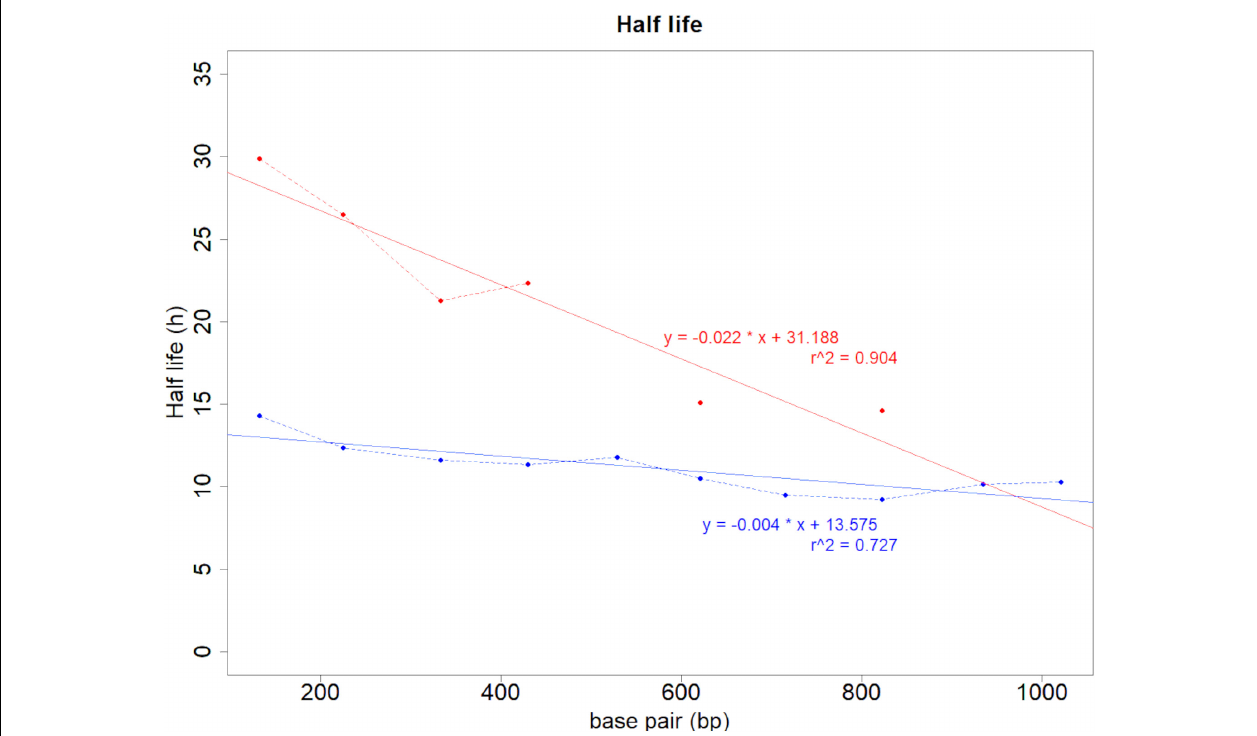
FIGURE 5 | Half-life results calculated from the decay rate. The vertical axis shows the half-life (hours), and the horizontal axis shows the sequence lengths. The blue line shows the change in total eDNA copy number, and the red line shows the change in intracellular eDNA copy number. At 529, 715, 935, and 1,021 bp of intracellular eDNA (red line), the half-life could not be statistically calculated because the eDNA copy number was obtained only at 2 time points or less.